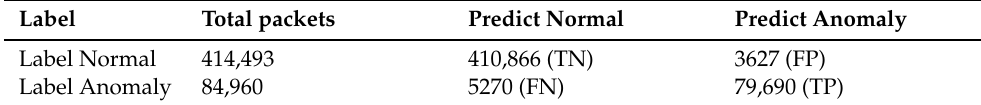
Table 12. Classification results of the ANC approach with the CIC-IDS2017